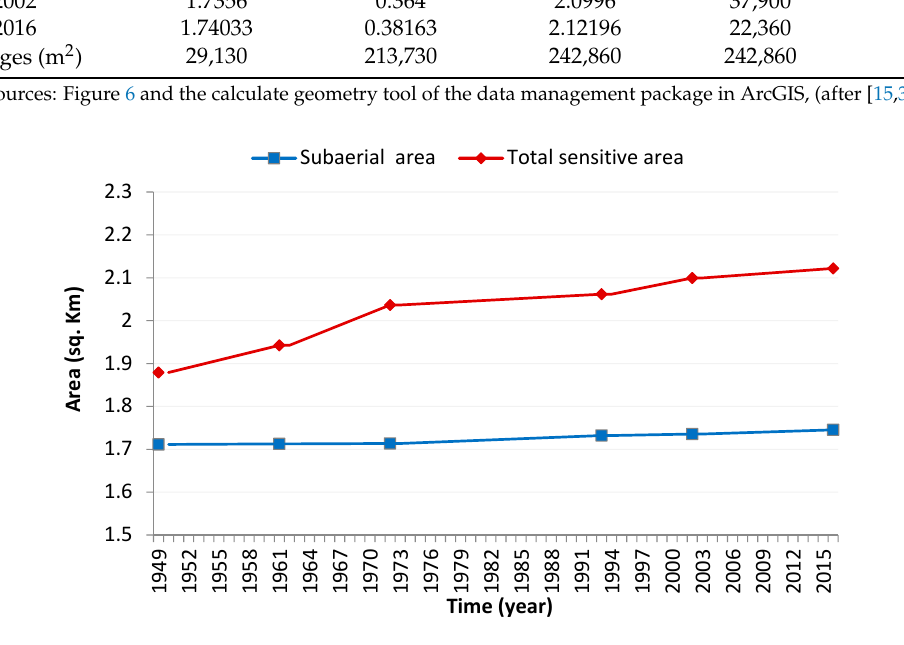
Figure 8. Wandandian deltaic growth, illustrating the overall growth of the delta itself and its levees/shorelines (blue), as well as the total growth of sensitive subaqueous areas (red).